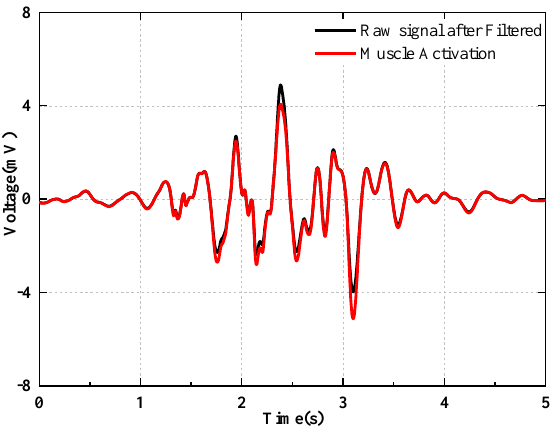
Figure 4. Extraction of muscle activity of biceps femoris.